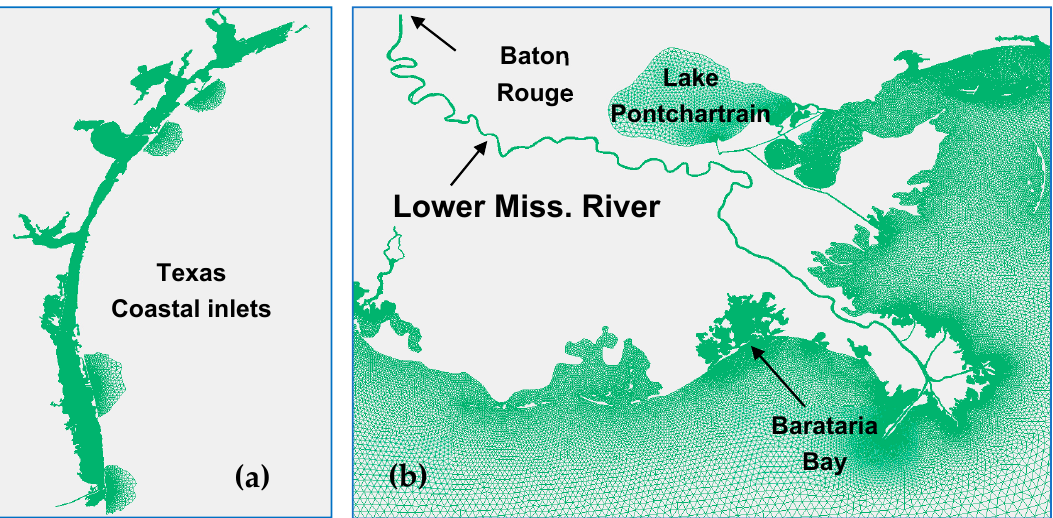
Figure 4. Close up view of the INGOFS model grid in two regions, ( a ) Texas coastal embayments, and ( b ) the lower Mississippi River course, Barataria Bay, and Lake Pontchartrain.